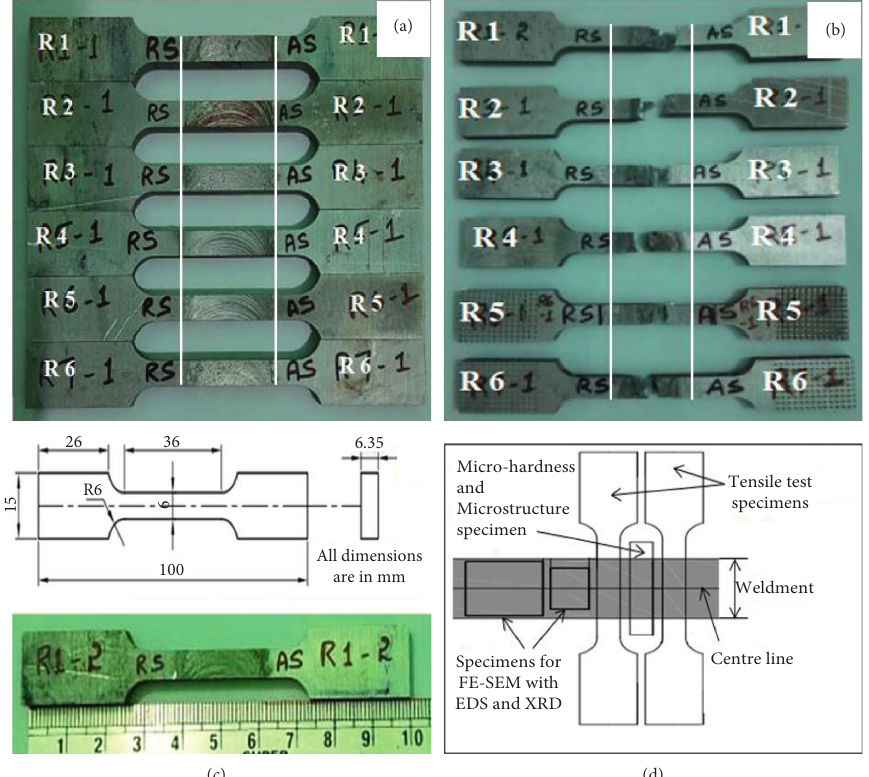
Figure 5: Tensile specimens: (a) before testing, (b) after testing, (c) schematic view of standard tensile specimen, and (d) representation of specimen extracted for various